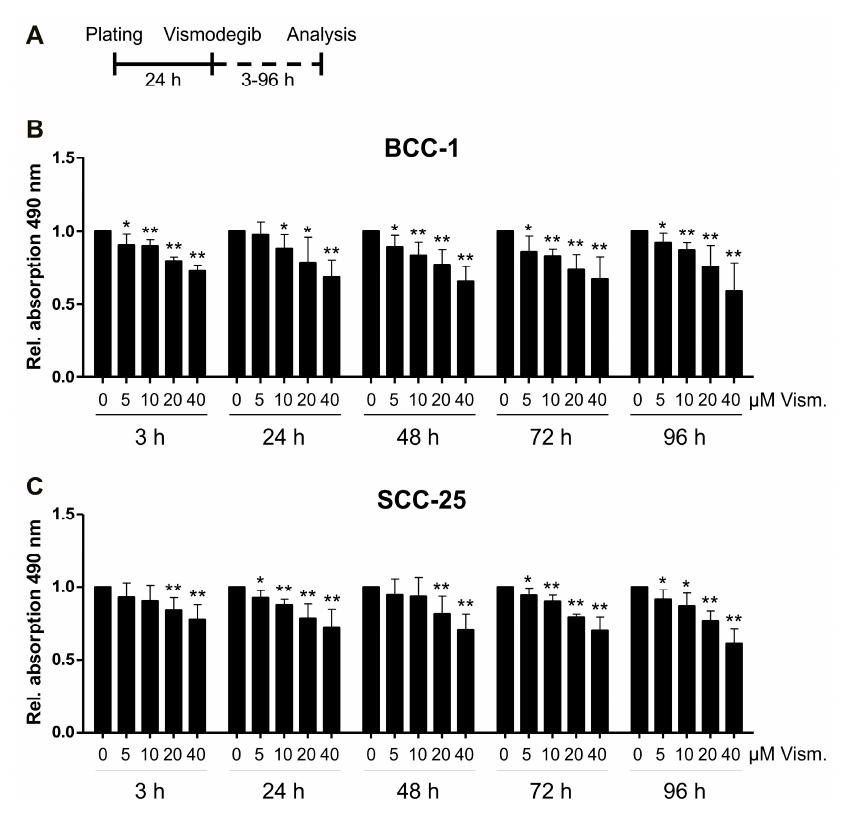
Figure 1. Vismodegib reduces the number of viable BCC-1 and SCC-25 cells. Relative quantification of cellular metabolic activity (i.e., number of viable cells) was performed for cells treated with vismodegib compared to dimethyl sulfoxide (DMSO) controls using a CellTiter 96 ® Aqueous One Solution Cell Proliferation (MTS) Assay. ( A ) Time schedule of vismodegib treatment and measurement of colorimetric cell proliferation assay. BCC-1 or SCC-25 cells were plated 24 h before treatment with vismodegib for 3 to 96 h before analysis. Metabolic activity is expressed as relative absorption at 490 nm. This assay was carried out in five independent experiments (each in quadruplicate) for BCC-1 ( B ) and SCC-25 ( C ) cells. The metabolic activity of controls was set to 1.0 (i.e., reference value) as indicated. Statistical significance was assessed by t -test; * p < 0.05, ** p < 0.01 (vismodegib- versus DMSO-treated cells). BCC, basal cell carcinoma; Rel., relative; SCC, squamous cell carcinoma; Vism.,